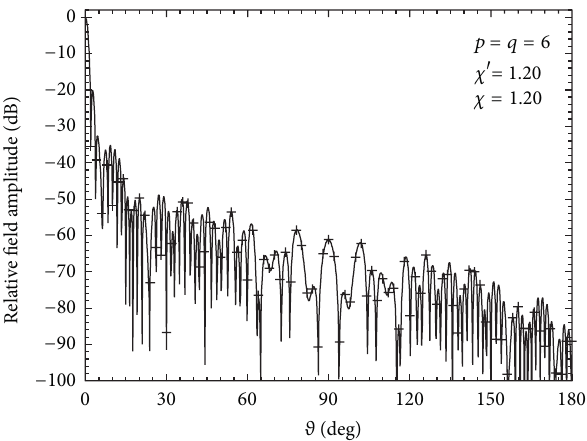
Figure 12: H-plane pattern. Solid line: exact. Crosses: reconstructed from NF measurements.